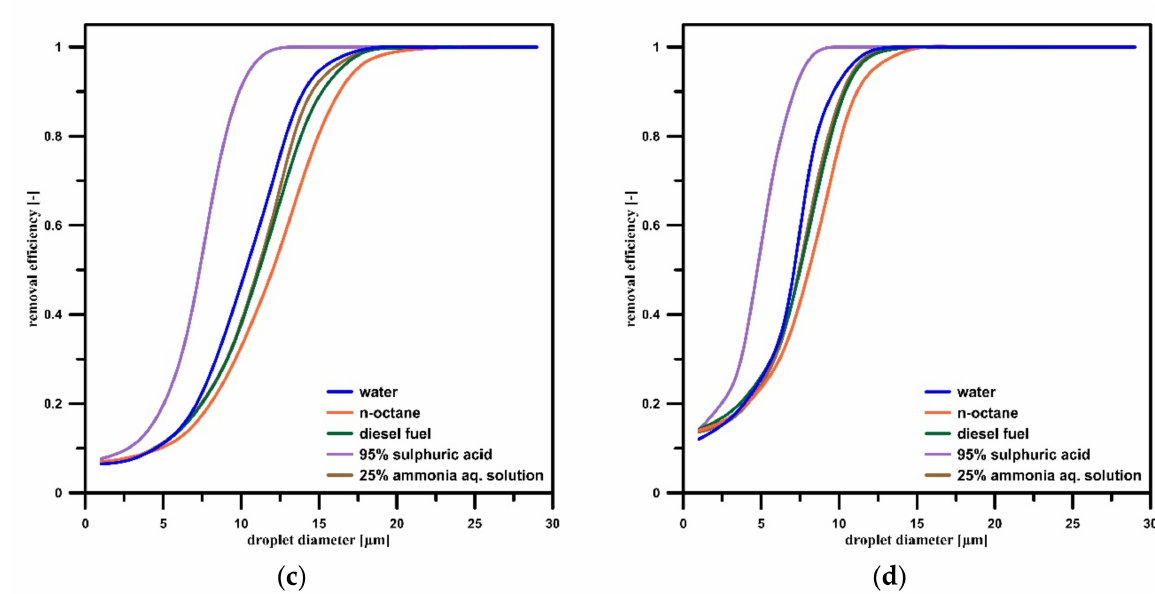
Figure 15. Comparison of calculated results of droplet removal efficiency for different media: ( a ) geometry A, inlet velocity 2 m s − 1 ; ( b ) geometry A, inlet velocity 4 m s − 1 ; ( c ) geometry B_10_0, inlet velocity 2 m s − 1 ; ( d ) geometry B_10_0, inlet velocity 4 m s − 1 .